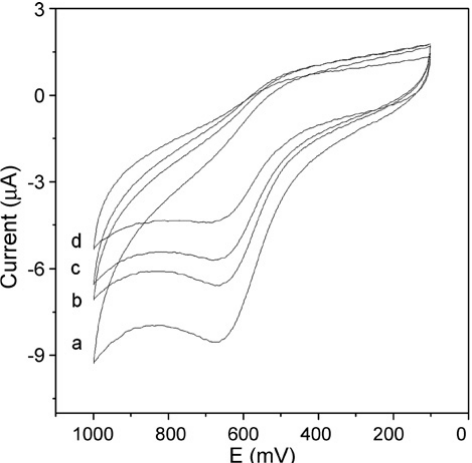
CVs of AChE/MWCNTs-Chi/GCE in pH 7.0 PBS containing 0.4mM acetylthiocholine chloride solution after incubation in (a) 0 x 10 -6 M (b) 1.5 x 10 -6 M. (c) 3.5 x 10 -6 M and (d) 5.2 x 10 -6 M triazophos solution for 10 min (reproduced with permission from Du et al.